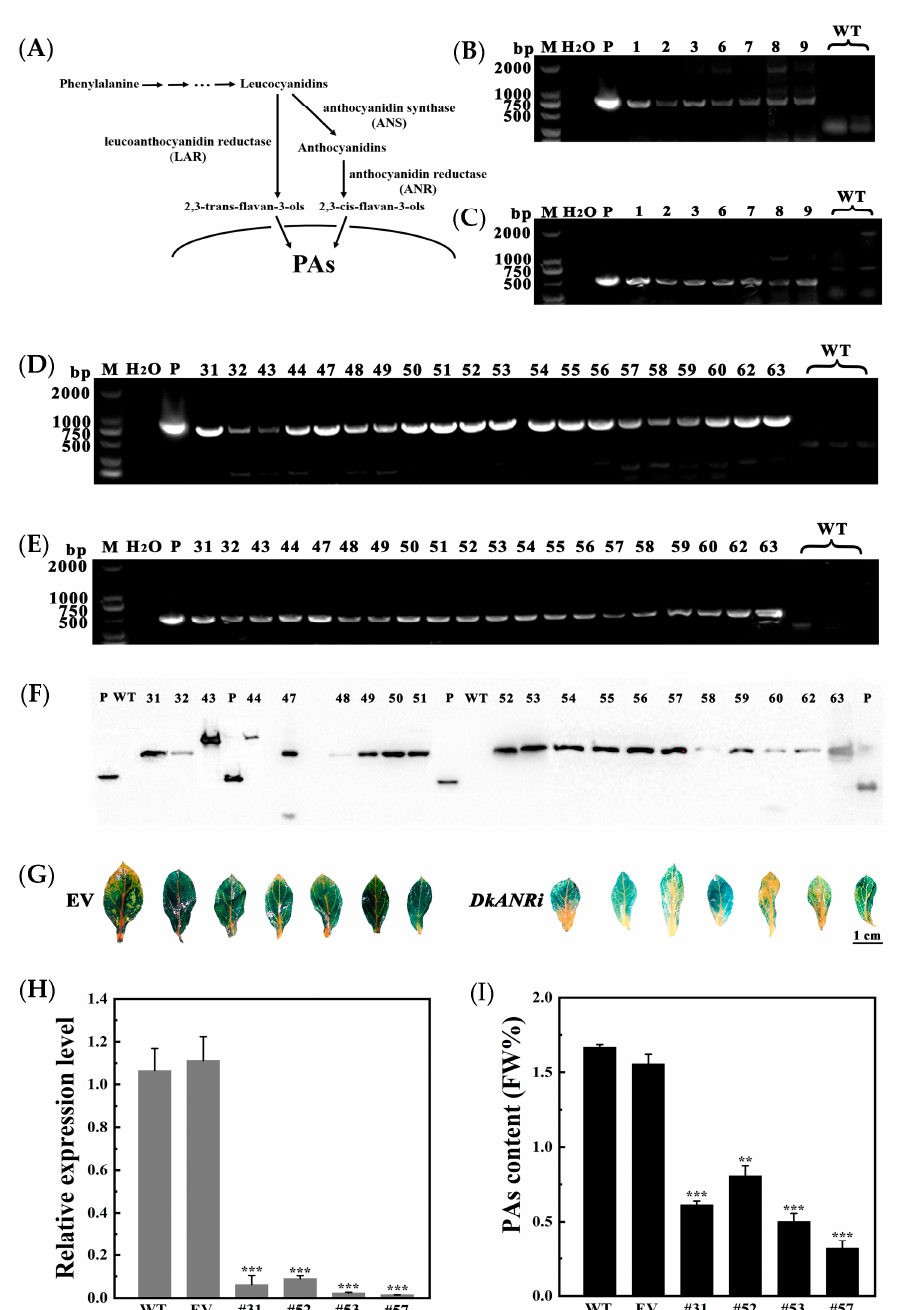
Figure 4. PCR amplification, DMACA staining of leaves, and DkANR expression and PAs contents of putatively positively transformed ‘Gongcheng Shuishi’ persimmon seedlings. ( A ) Brief scheme for the biosynthesis of proanthocyanidin. ( B ) PCR analysis of the transformed plants with EV using the hyg primer. ( C ) PCR analysis of the positively transformed plants with EV using the 35S primer. ( D ) PCR analysis of the transformed plants with DkANRi using the hyg primer. ( E ) PCR analysis of the positively transformed plants with DkANRi using the 35S primer. ( F ) Southern blot analysis of the positively transformed plants with DkANRi . ( G ) Analysis of PAs content in the leaves of the transgenic plants by 4-dimethylaminocinnamaldehyde (DMACA) staining. ( H ) Transcript level of DkANR in the transgenic plants with EV and DkANRi . ( I ) PAs content of WT, EV, and DkANRi transgenic plants. WT and EV represent the wild-type persimmon DNA and empty vector transgenic plant DNA, respectively. P represents the empty vector plasmid DNA. Asterisks (*) indicate significantly different values, **, p ≤ 0.01; ***, p ≤ 0.001. Bar = 1.0 cm.